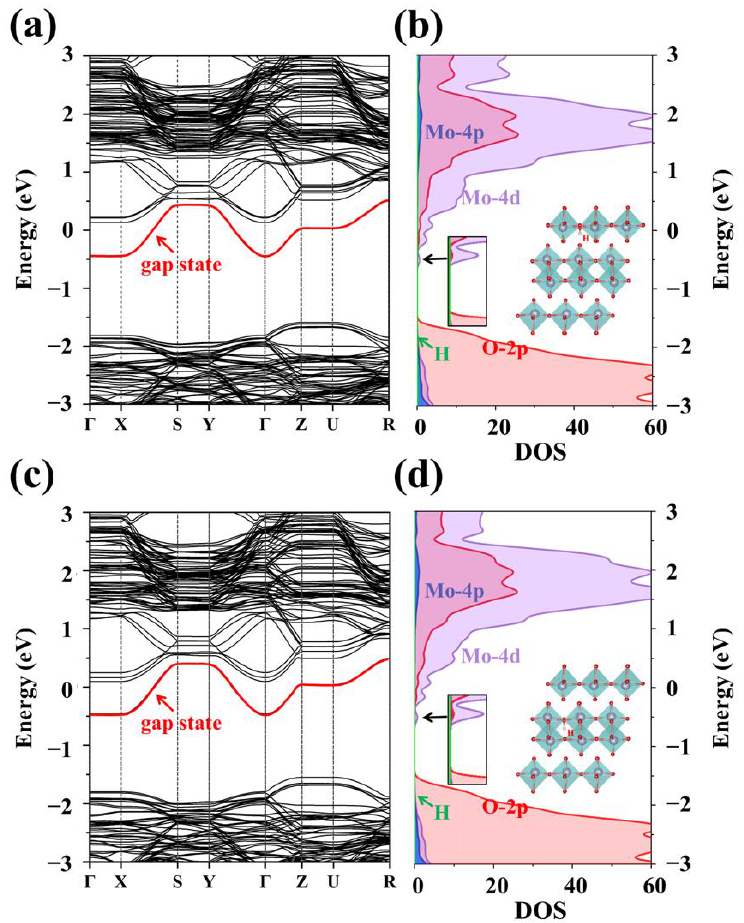
Figure 3. ( a ) Band structure of interlayer doped H atoms. ( b ) Band structure of intralayer doped H atoms. ( c ) Density of states of interlayer doped H atoms. ( d ) Density of states of intralayer doped H atoms.